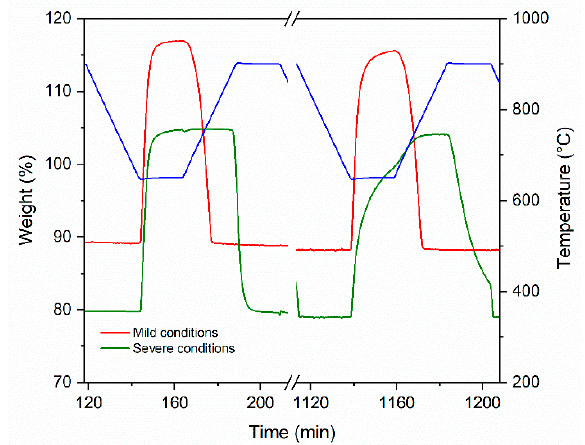
Figure 7. TGA weight profiles vs. time of the CCZ40 sorbent under mild conditions (red line) and under severe conditions (green line) for the first and last cycles.